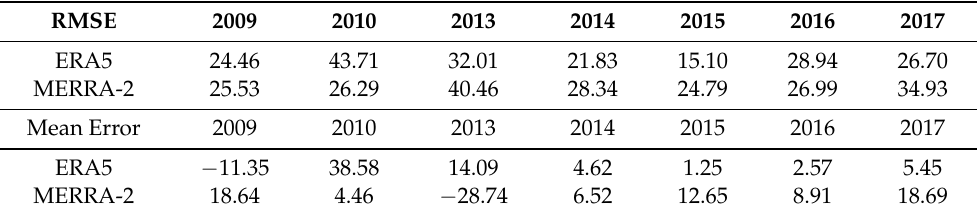
Table 2. Comparisons between modeled and observed HS (cm) (RMSE and mean error).